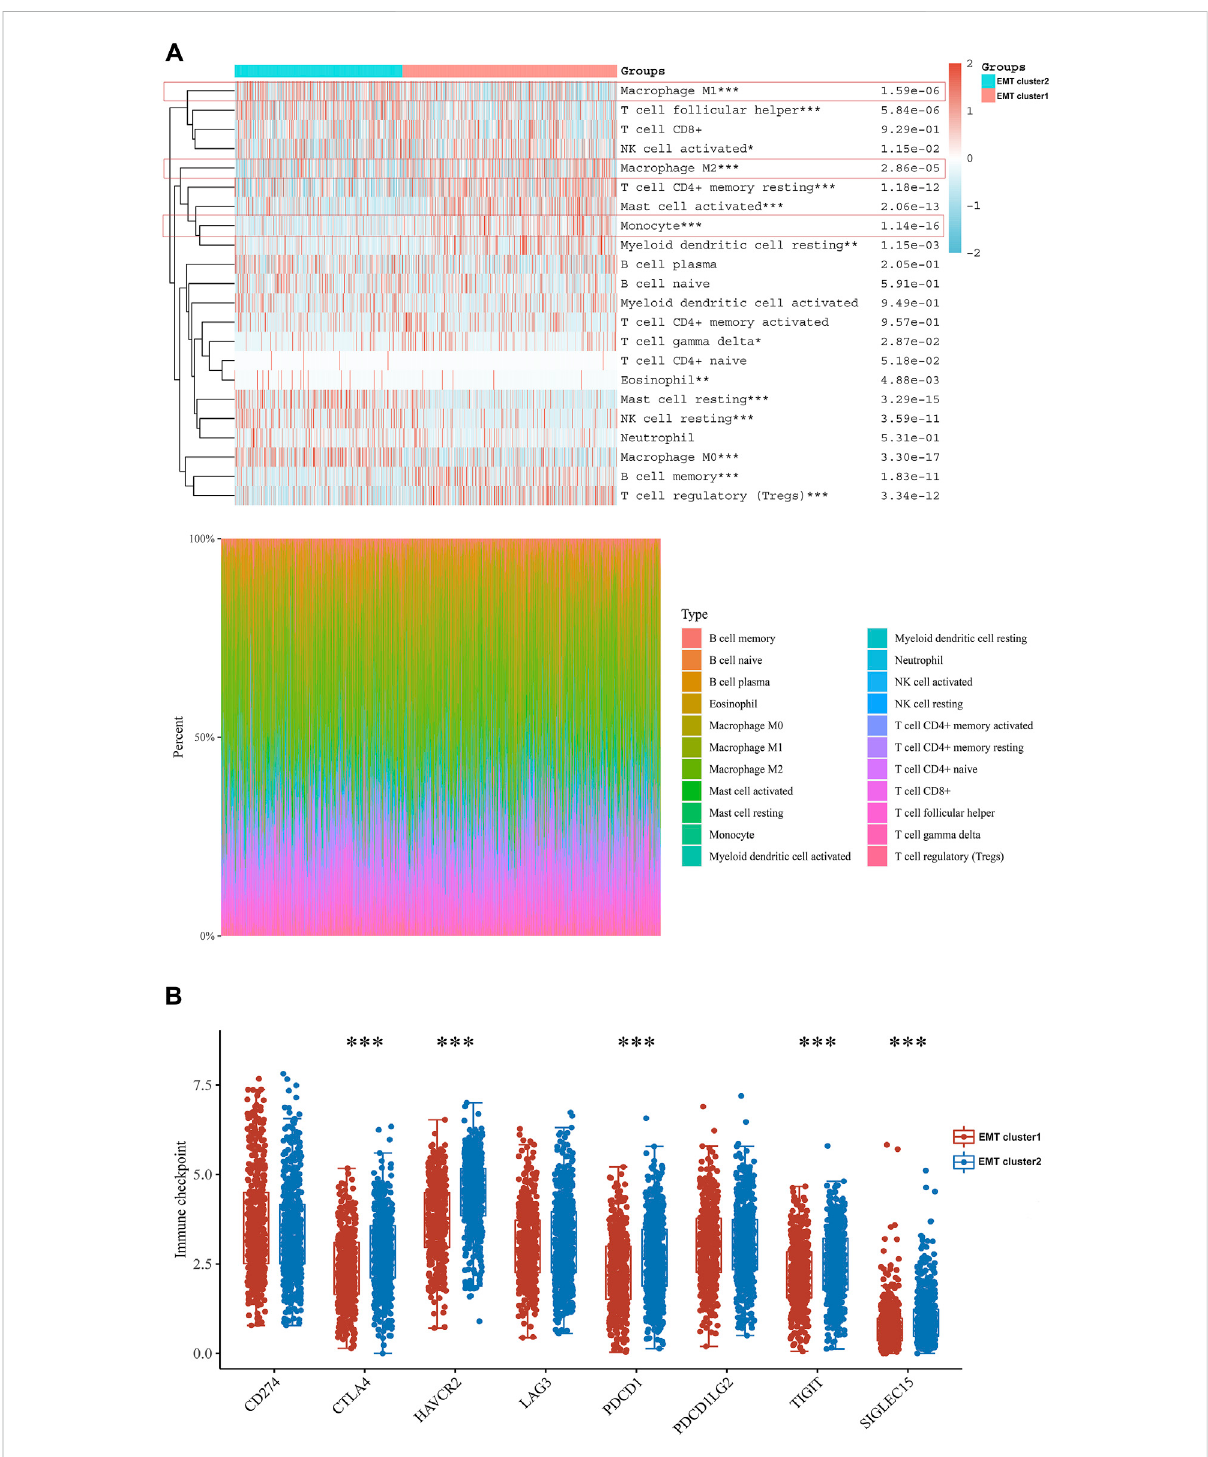
FIGURE 2 EMTclusters dividedifferential tumor-in fi ltrated lymphocytes andimmunemicroenvironment. (A) Wefound theconnection between different immune cells and EMT. Red represents positive correlation while blue represents negative correlation. (B) Expression distribution of immune checkpoint molecules in C1 and C2